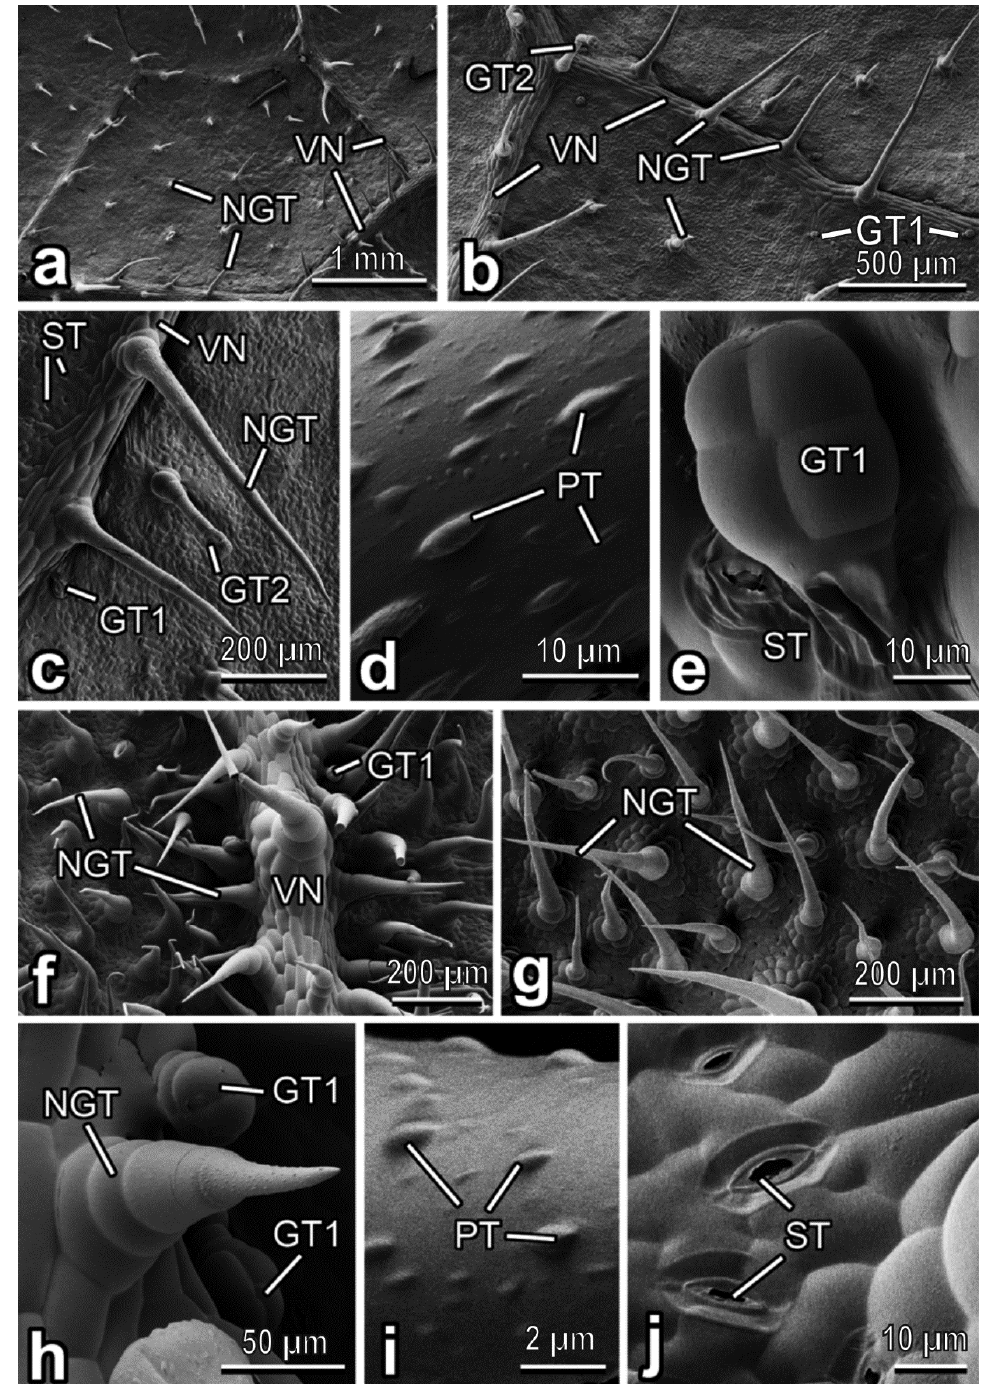
Figure 4. Abaxial leaf side of Cucumis sativus ( a – e ) and Cucurbita moschata ( f – j ), cryo-SEM. ( a ) General view of the leaf surface. ( b , c , f ) Leaf surface with the vein(s). ( d , i ) Microsculptured surface of the non-glandular trichome. ( e ) Glandular (short-stalked) trichome. ( g ) Leaf surface between the veins. ( h ) The vein bearing both non-glandular and glandular (short-stalked) trichomes. ( j ) Stomata. Abbreviations: GT1: clavate short-stalked glandular trichome; GT2: capitate long-stalked glandular trichome; NGT: non-glandular trichome; PT: protrusion; ST: stoma; VN: vein.